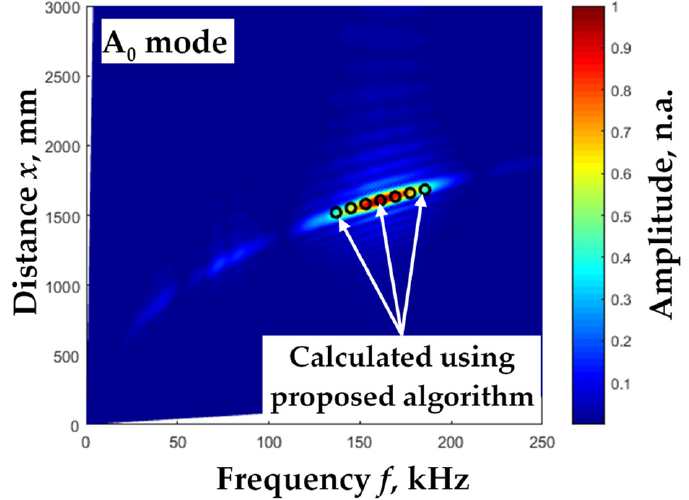
Figure 11. The experimentally calculated phase velocity dispersion curve values of the Lamb wave A0 mode using the proposed algorithm (dots) and the calculated phase velocity dispersion curve using 2D FFT method (color).